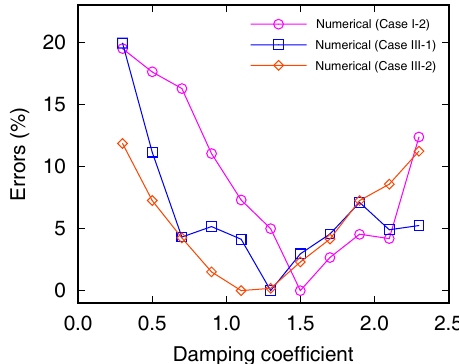
Figure 8. Errors of numerical results for each model compared with analytical solution according to the damping coefficients ( D s